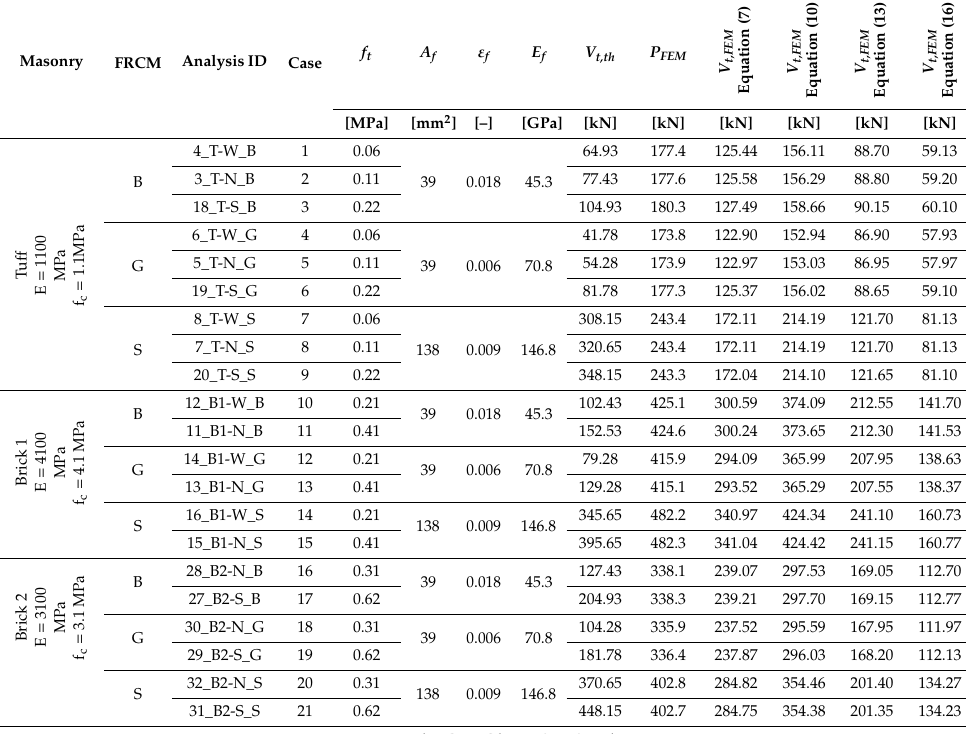
Table 2. Theoretical and numerical results for the strengthened panels for di ff erent mechanical properties of masonry and of FRCM